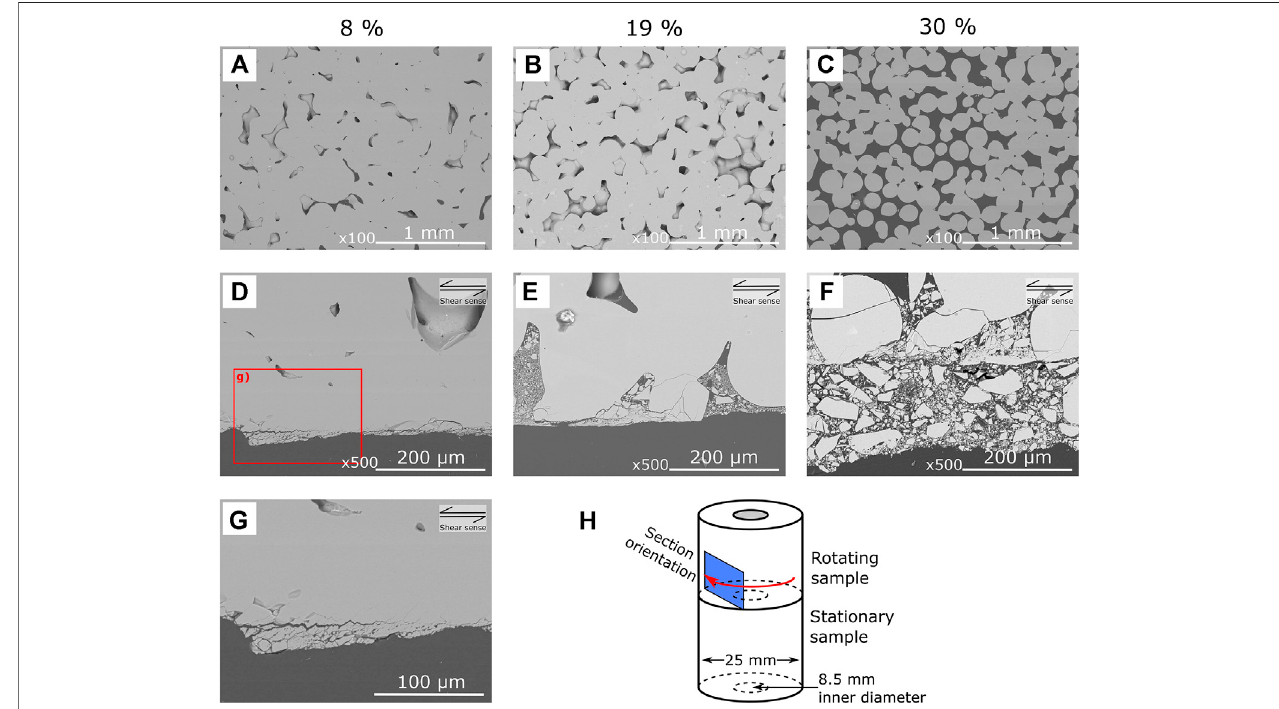
FIGURE 7 | Backscattered electron (BSE) images of samples with different porosity. Texture of the sintered glass samples highlighting pore structure prior to testing for (A) 8%, (B) 19% and (C) 30% porosity samples. (D) Damage zone of an 8% porosity sample that experience 9.04 m of slip at 1 MPa at 0.1 m s − 1 showing minimal penetration of damage ( < 50 µm) and Riedel shearing. (E) Damage zone of a 19% porosity sample that experienced 8.64 m of slip at 1 MPa at 0.1 m s − 1 with morefracturingatporeedgesandaccumulationof fi ne-grained(maximum50 µmtosmallerthan1 µm)gougematerialwithinpores. (F) Damagezoneandgougeof a 30% porosity sample that experience 2.79 m of slip at 1 MPa at 0.2 m s − 1 with large fragments up to 100 µm in size in a gouge layer up to 350 µm thick. (G) Zoomed area of panel D (shown by the red inset box) at higher magni fi cation to highlight Riedel structures and the absence of gouge. (H) A schematic of thin section orientation (same for all samples) within the sample assembly. Shear for panels D – G is left-lateral (sinistral) as indicated by the schematic.